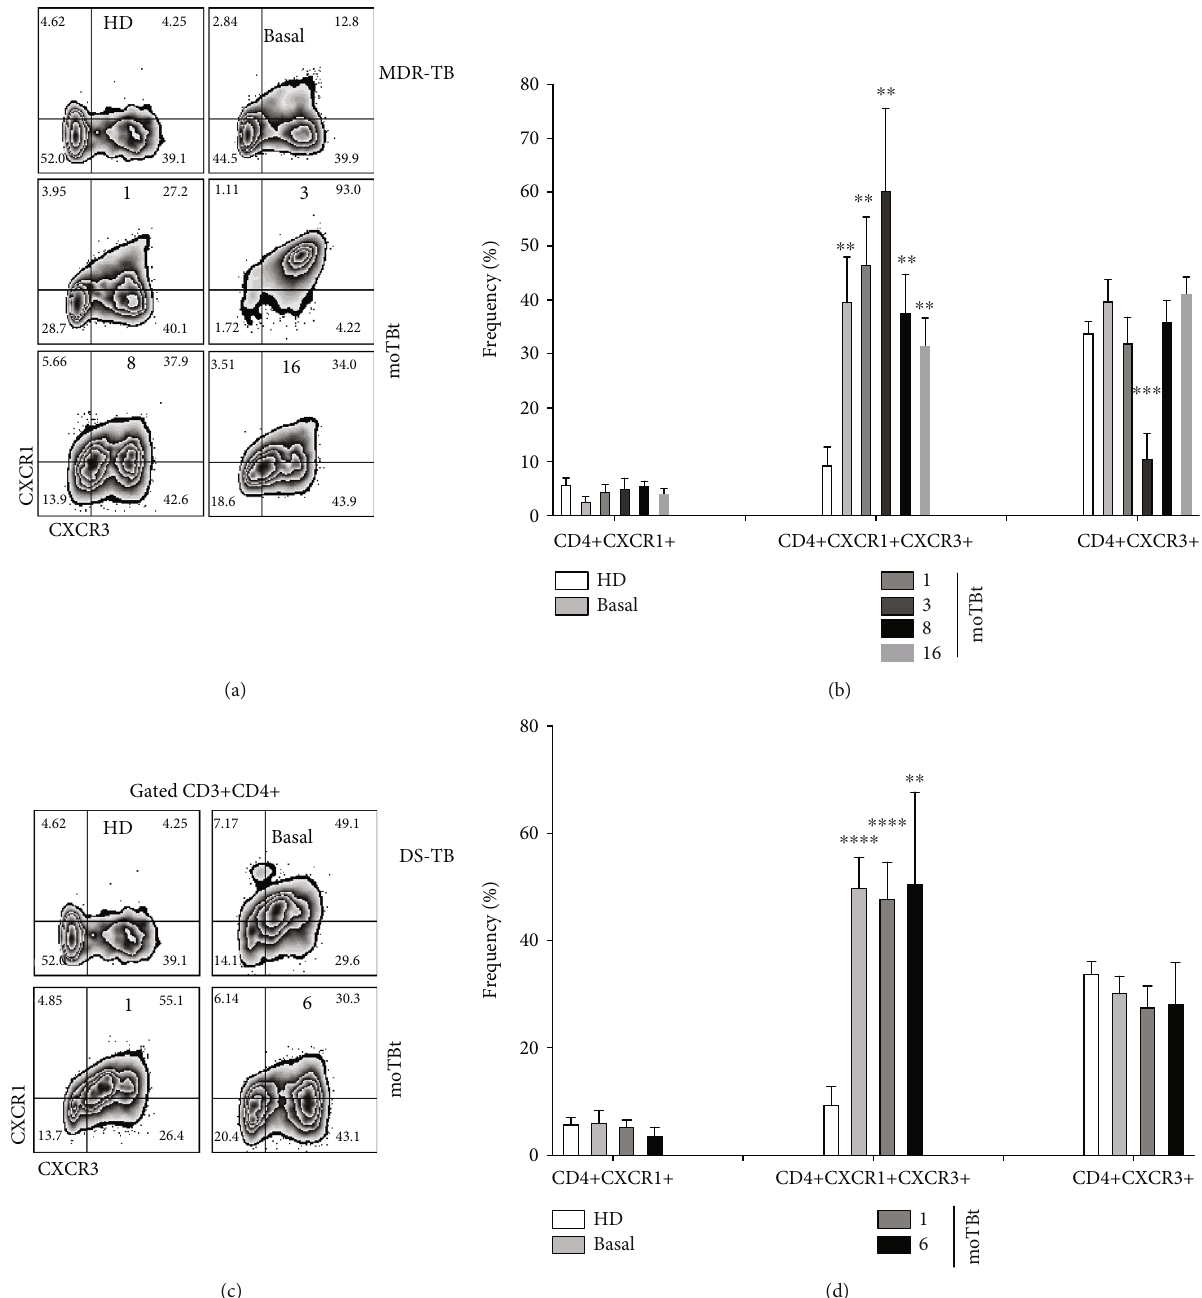
Figure 6: Expression of CXCR1 and CXCR3 in CD4+T cells from MDR-TB and DS-TB patients. Representative zebra plots showing the strategy used to determine the expression of CXCR1 and CXCR3 CD3+CD4+ T cells. Peripheral blood mononuclear cells (PBMCs) from multidrug-resistant (MDR-TB) or drug-sensitive (DS-TB) patients were obtained at di ff erent times before and after anti-TB treatment and used for phenotypical characterization by fl ow cytometry (a and c, respectively). (b) Frequency of CD4+CXCR1+, CD4+CXCR1+CXCR3 +, and CD4+CXCR3+ T cell subpopulations in MDR-TB patients (HD: n = 6 , MDR-TB: basal, 1, and 3 moTBt n = 10 , 8 moTBt n = 8 , and 16 moTBt n = 7 ). (d) Frequency CD4+CXCR1+, CD4+CXCR1+CXCR3+, and CD4+CXCR3+ T cell subpopulations in DS-TB patients (HD: n = 6 , DS-TB: basal and 1 moTBt n = 10 , and 6 moTBt n = 8 ). Bar graphs show means ± standard errorof the mean ð SEM Þ . Di ff erences between patient groups and HD at each time point were analyzed using multiple Student ’ s t -test corrected for multiple comparisons using the Sidak – Bonferroni method. ∗ p < 0 : 05 , ∗∗ p < 0 : 01 , ∗∗∗ p < 0 : 001 , and ∗∗∗∗ p < 0 : 0001 . moTBt: months of antituberculosis